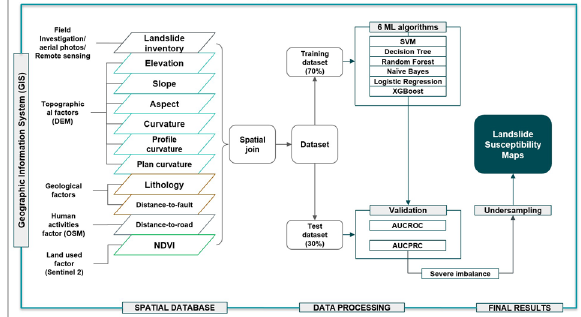
Figure 4. Workflow diagram showing the methodology